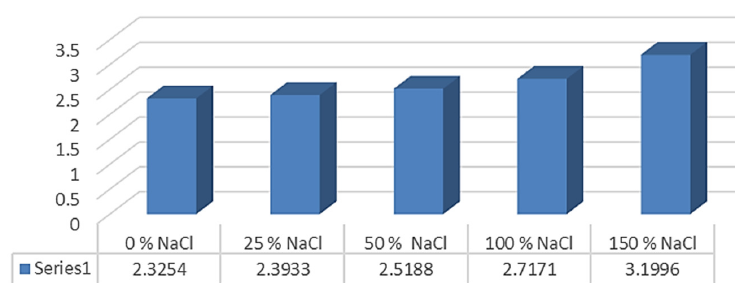
Figure 4. Effect of salt stress on average germination time (AGT)